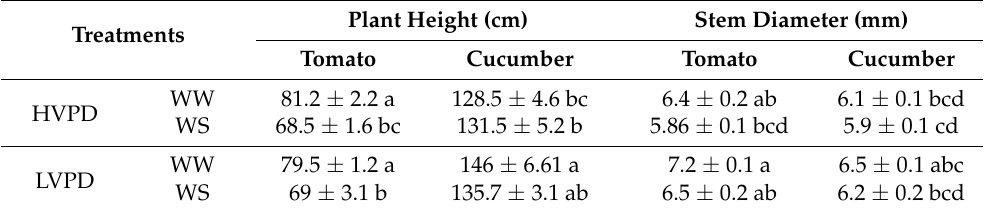
Table 2. Effects of VPD and soil moisture on the growth of tomato and cumber plants.